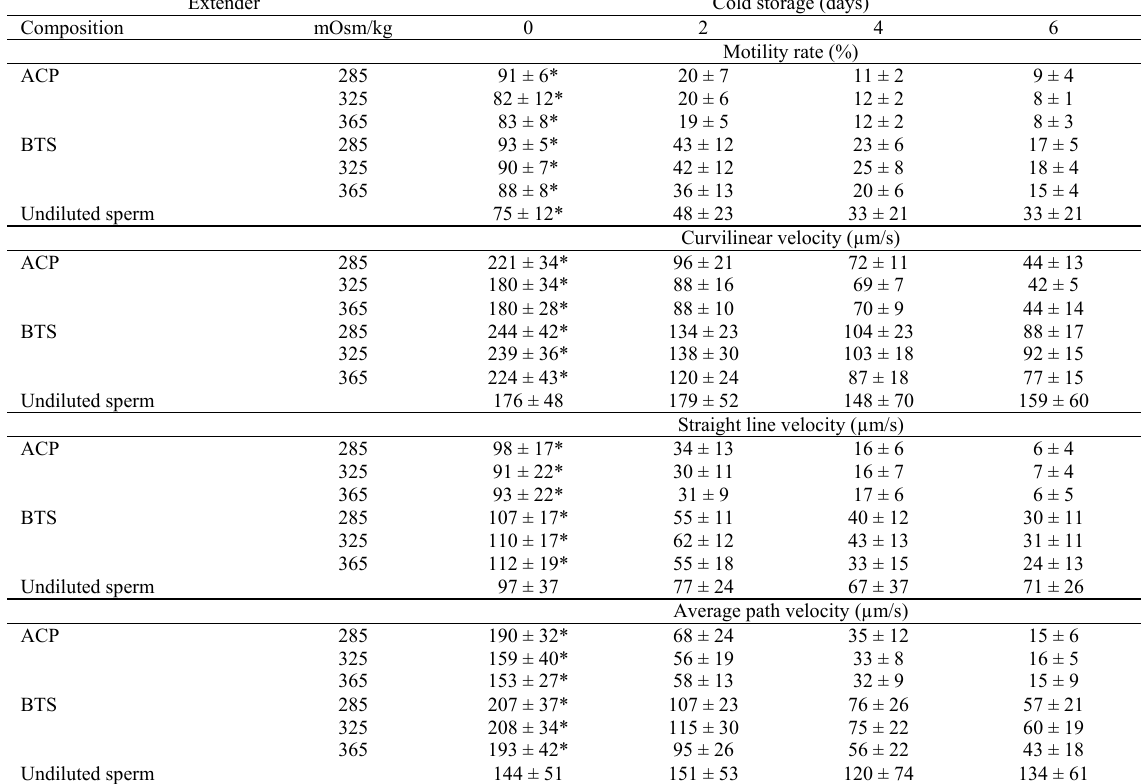
Table 2. Motility rate and velocities (mean ± SD) of Prochilodus lineatus (n=15 males) sperm diluted in six extenders composed of two compositions x three osmolalities. Sperm was cold stored at 6-8°C for six days. Undiluted sperm served as control. ACP: Powdered Coconut Water™; BTS: Beltsville Thawing Solution™. There was no difference of extender osmolality on sperm quality (P>0.05; MR-MANOVA). * Means within the same line followed by this symbol are significantly higher than the others (comparison among days after cooling; P<0.05;